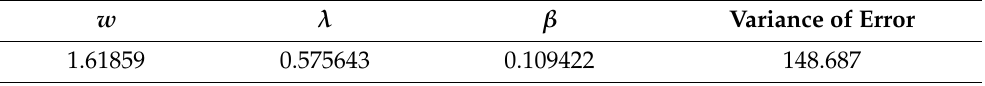
Table 2. Fitted parameters of the GARCH(1,1) process of the